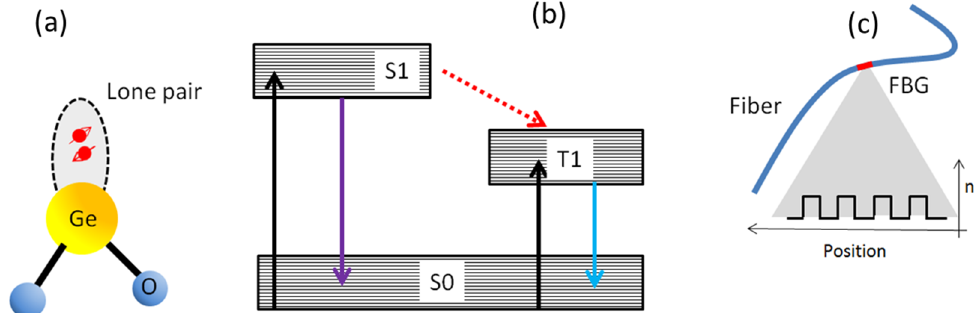
Figure 3. ( a ) Structural model of germanium lone pair center (GLPC); ( b ) Energy levels scheme of GLPC showing the absorptions due to S0–S1 and S0–T1 transitions (black arrows), the emissions due to S1–S0 (violet arrow) and T1–S0 (blue arrow) and the non-radiative transition named intersystem crossing (red dashed arrow); ( c ) representation of a FBG (fiber Bragg grating), which consists of a periodic alteration of the refractive index.